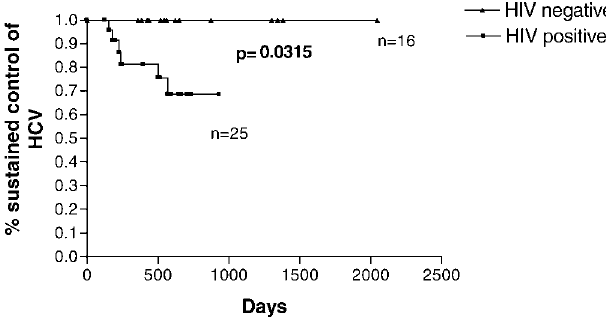
Figure 6. Recurrent Viremia in Persons with Evidence of Spontaneous Control of HCV Serial HCV VL determinations were performed in persons demonstrating spontaneous control of HCV. Data were censored at the last available time point. Six of 25 participants experienced recurrent HCV viremia in the HIV þ group, while 0 of 16 HIV (cid:1) participants experienced recurrence. The median time of follow-up did not differ between groups.